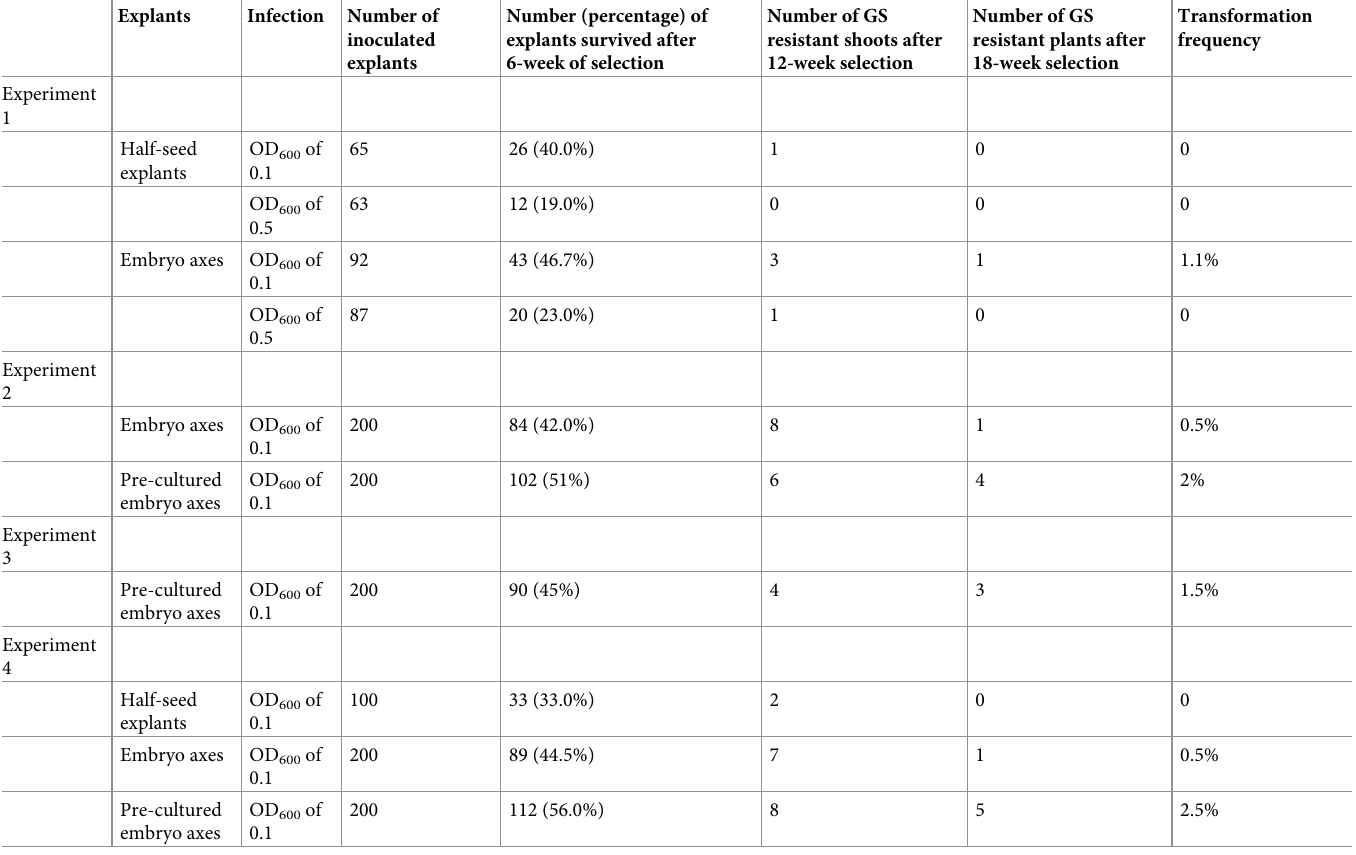
Table 1. Summary of three transformation experiments of common bean ‘Olathe’.